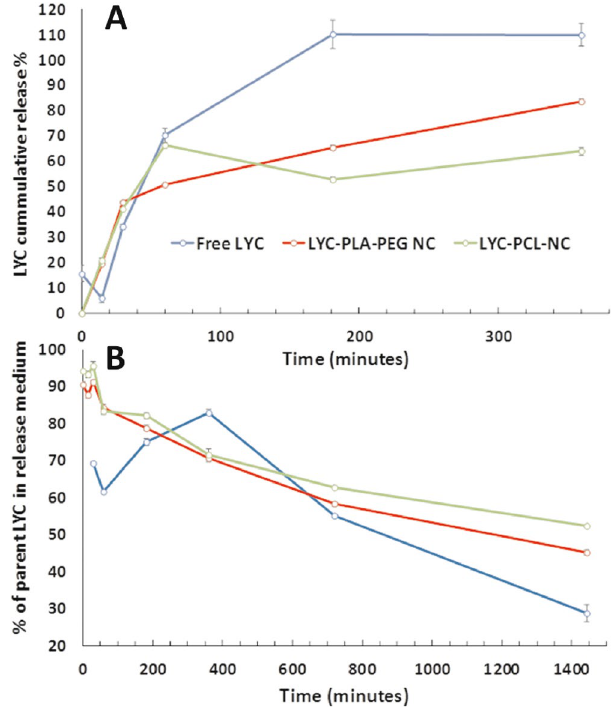
Figure 3. Lychnopholide (LYC) dissolution and release profiles from nanocapsules (graph A) and percentage of parent lychnopholide (graph B ) determined in phosphate buffered saline (pH 7.4) with 40% v/v of mice plasma. Parent LYC is the LYC content determined in the release medium divided by the total LYC placed in the release medium × 100. Metabolites or degradation products were neither identified nor